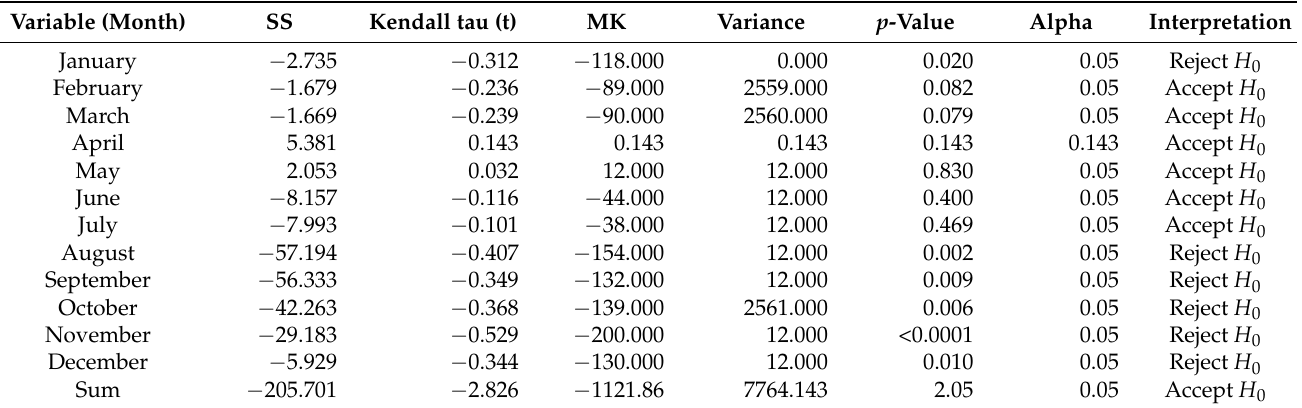
Table 12. SS and MK test results for the Mostovoi runoff data